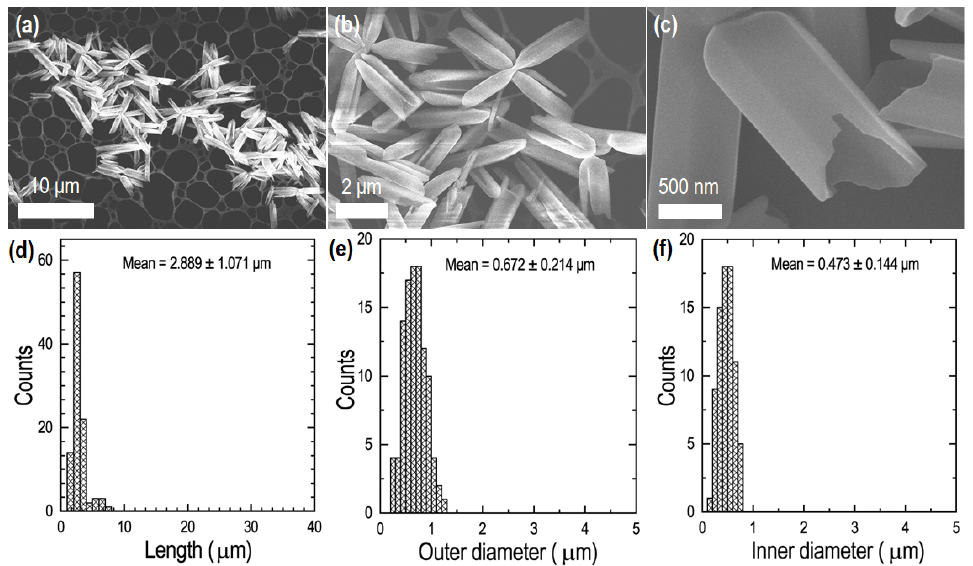
Figure 1. The surface morphology and size distribution of the CHFCs: ( a – c ) SEM images; ( d ) Histo- gram of the length distribution profile; ( e ) Histogram of the outer diameter distribution profile; ( f ) Histogram of the inner diameter distribution profile.